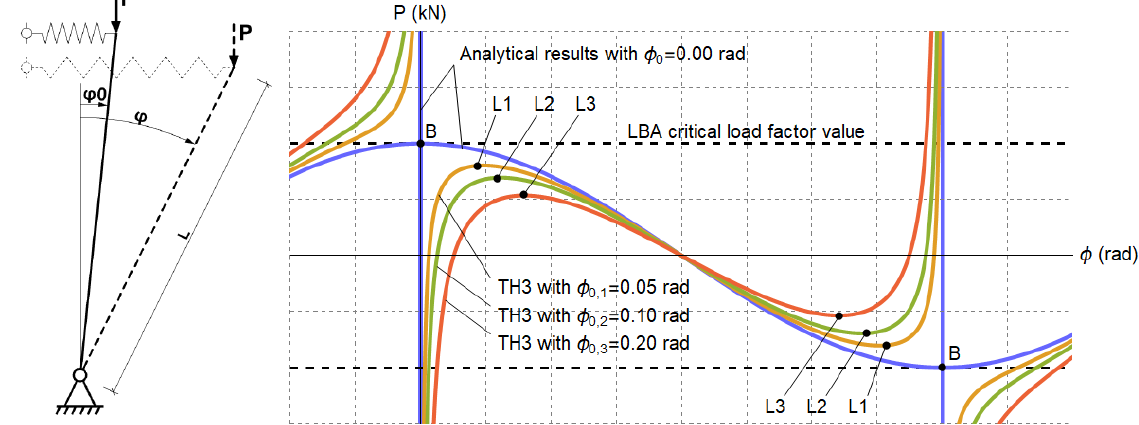
Figure 2: Comparison of sample equilibrium paths with the snap-through instability (B – bifurcation point, L – limit point).